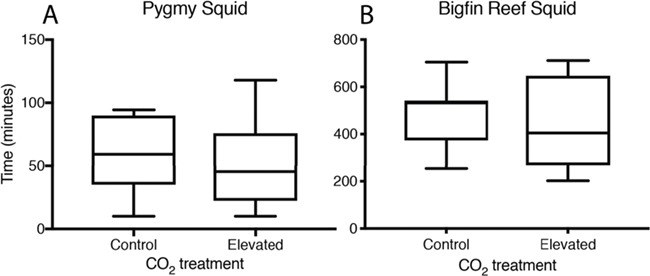
Recovery time that pygmy squid (A) and bigfin reef squid (B) required to reach a stable routine oxygen uptake rate following exhaustive exercise at current-day control and elevated CO2 treatment levels; boxplots show the median and interquartile range and the minimum and maximum range of the data (Note: the y-axis for pygmy squid ranges from 0–150 minutes while the y-axis for bigfin reef squid ranges from 0–800 minutes).